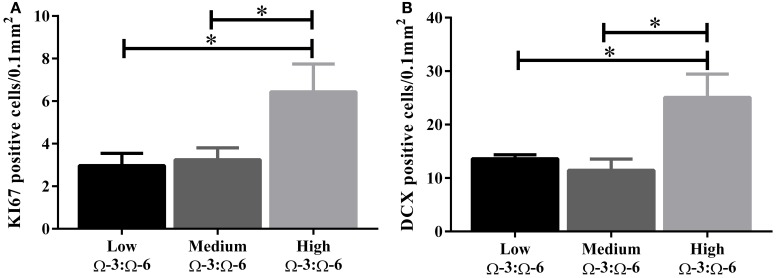
Effect of Ω-3:Ω-6 diet on neurogenesis in the dentate gyrus. Number of KI67 positive cells (A) and DCX positive cells (B) in the dentate gyrus. Data analyzed by One-Way ANOVA within strains with Tukey's post-hoc test, *p < 0.05 as indicated on figure. All data represented as mean ± SEM (n = 5/group).